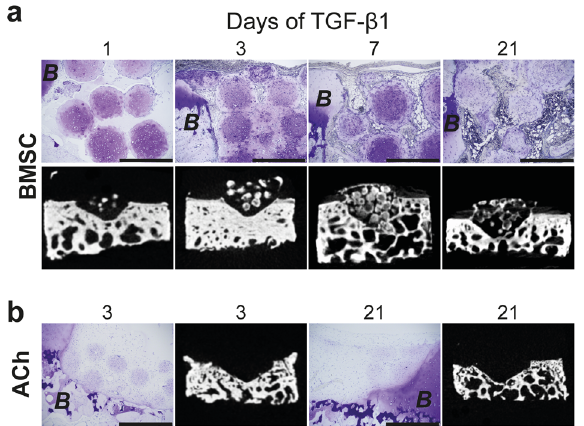
Fig. 5 Micro -pellet tissue formation in vivo. Analysis of micro -pellets formed from a BMSCs or b ACh implanted subcutaneously in NSG mice for 8 weeks in bovine defect models. Histological sections showed that BMSC and ACh micro -pellets appeared highly remodeled with reduced GAG staining (Toluidine blue), and only BMSCs formed bone-like tissues (scale bars, 500 μ m). Micro-CT analysis con fi rmed the presence of mineralized tissue in BMSC micro -pellets, unlike ACh micro -pellets. Representative images are shown for 21 day in vitro differentiated tissues with TGF- β 1 exposure for days indicated above the images. Surrounding bovine cartilage and bone tissue is marked with the letter “ B ” to indicate bovine Cell fate and RNA-seq analysis . To resolve globally modi fi ed gene expression by TGF- β 1 between BMSC and ACh cultures, and to identify potential targets to inhibit hypertrophy, we per- formed bulk RNA-seq analysis. A schematic of the experiment is shown in Fig. 6a with blue and gray lines representing culture days with ( + )TGF- β 1 and without ( – )TGF- β 1, respectively, and red arrows representing the day of analysis. We analyzed cultures